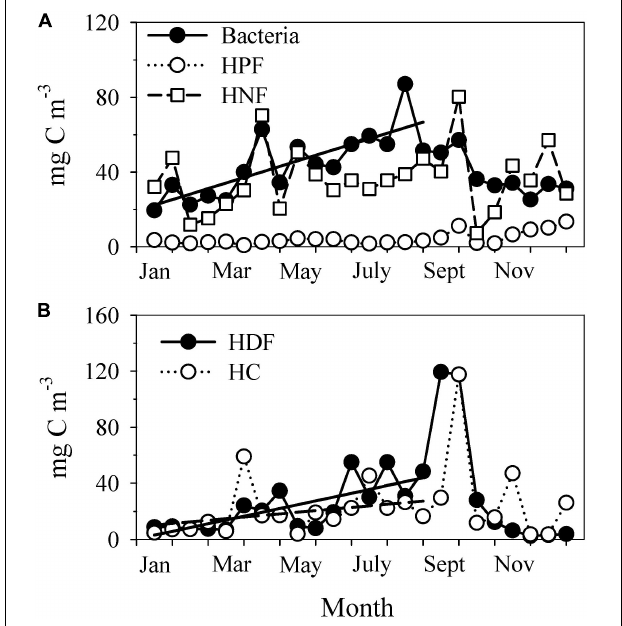
FIGURE 7 | Time series of (A) the biomass of heterotrophic bacteria (Bacteria), heterotrophic picoflagellates (HPF) and heterotrophic nanoflagellates (HNF) and (B) the biomass of heterotrophic dinoflagellates (HDF) and heterotrophic ciliates (HC). The continuous line in (A) describes the seasonal increase in heterotrophic bacteria: Y = (18 ± 6) + (3 ± 0.6)X; r 2 = 0.62; n = 16; p = 0.0003. In (B) , the continuous line denotes the seasonal increase in HDF: Y = (2 ± 6) + (2 ± 0.6)X; r 2 = 0.49; n = 16; p = 0.002. The dashed line shows the trend for HC that was not